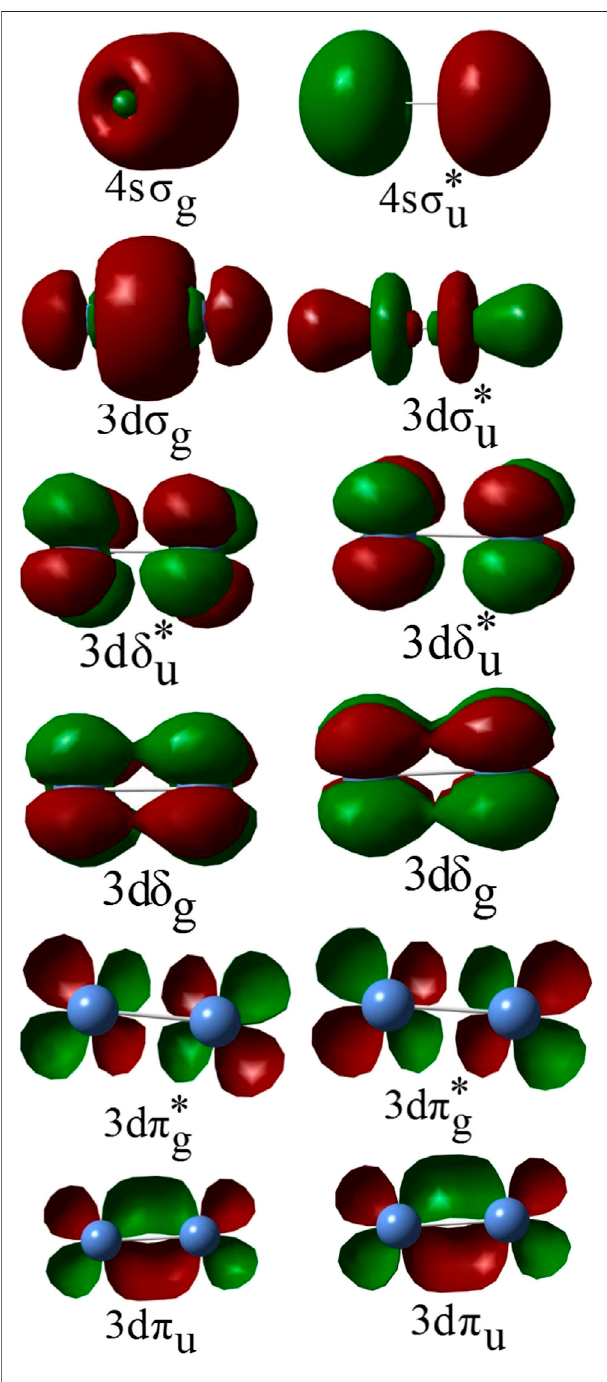
FIGURE1| ExampleofMCSCF3d-and4s-derivedmolecularorbitalsof the Ni 2 molecule.